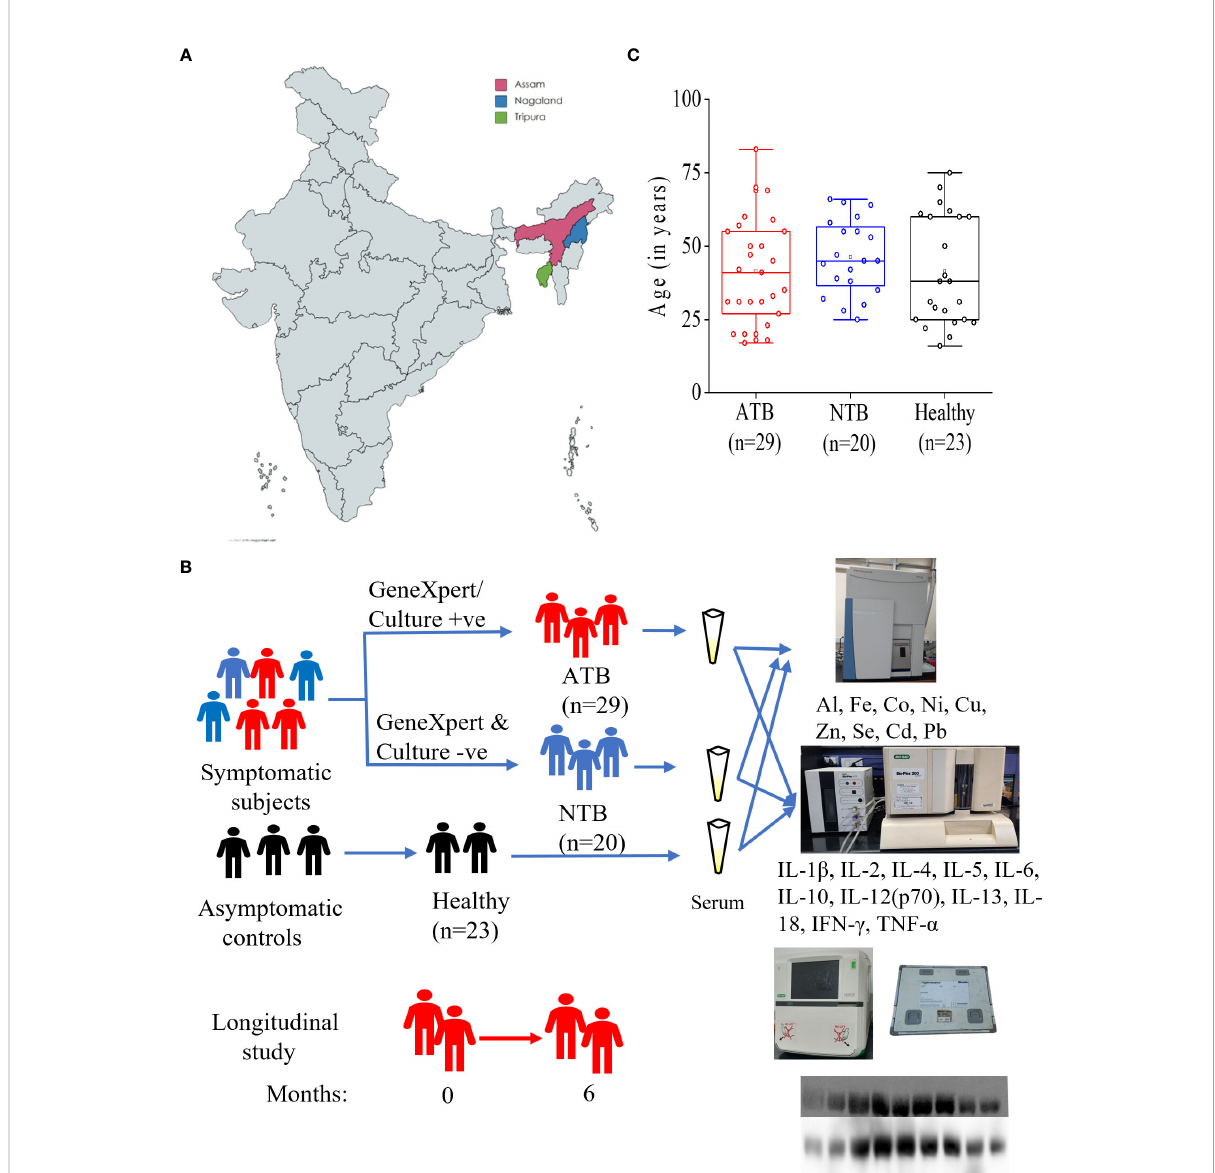
FIGURE 1 Schematic representation of study cites (A) , subject classi fi cation for serum elemental, cytokine and iron metabolism related protein analyses (B) . Box plot representing the age of active tuberculosis (ATB), non-tuberculosis (NTB) and healthy control subjects (C)